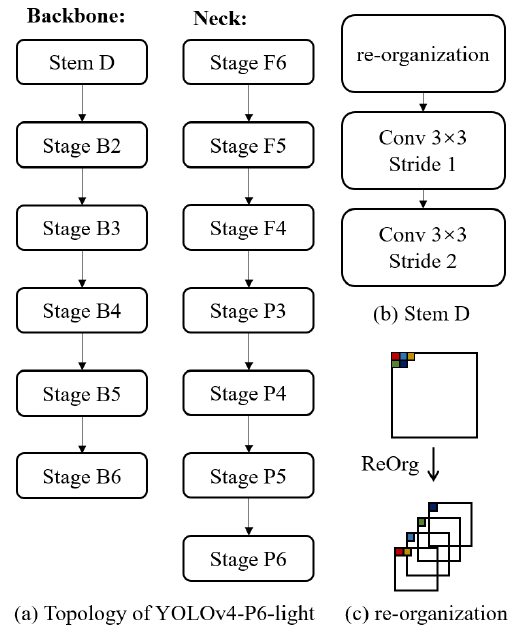
Figure 2 . The illustration of YOLOR (Wang et al., 2021).